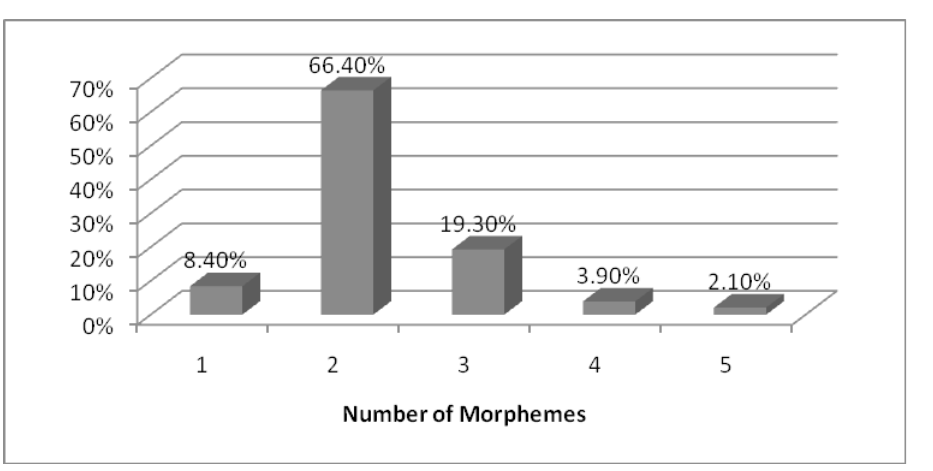
Figure 5. Percentage of Numerals with a Different Number of Morphemes There are only two uni-morphemic numerals du ‘two’ and dešimt ‘ten’, but they are rather frequent (8.4% of all